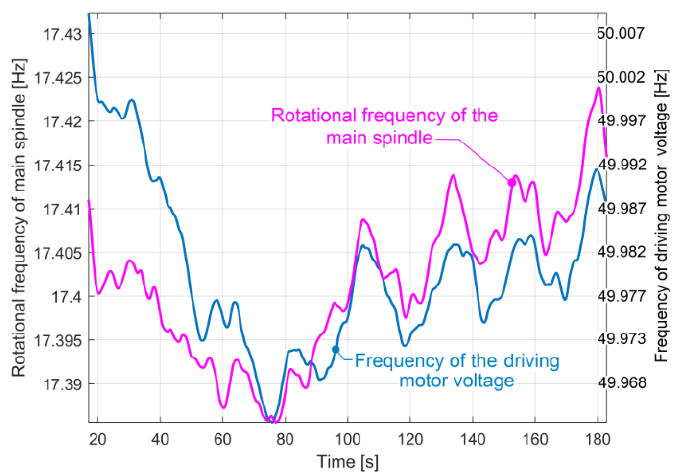
Figure 13. Low-pass filtered rotational frequency evolution of the main spindle and supplying voltage frequency evolution of the driving motor.